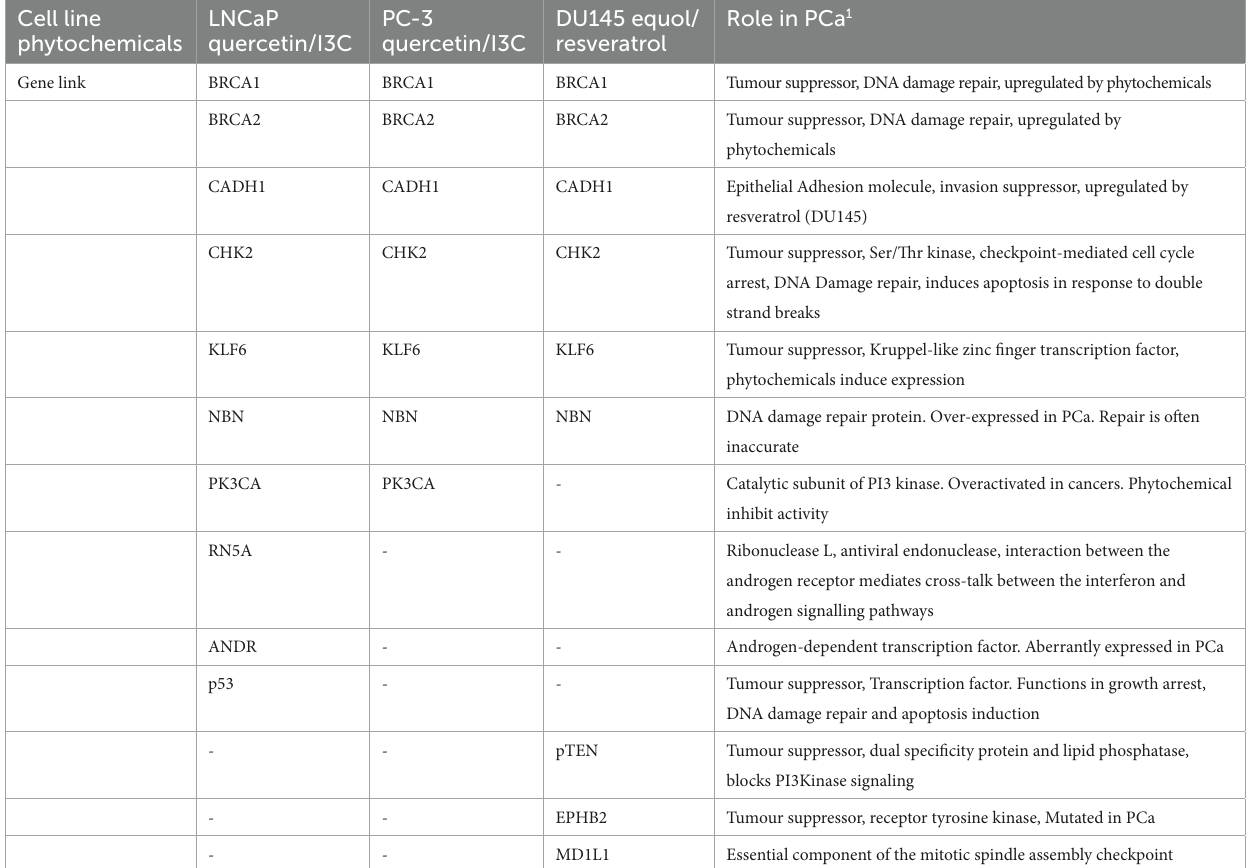
TABLE 2 Cell-line-dependent linkages of most potent synergistic phytochemical combinations to prostate cancer genes. Cell line